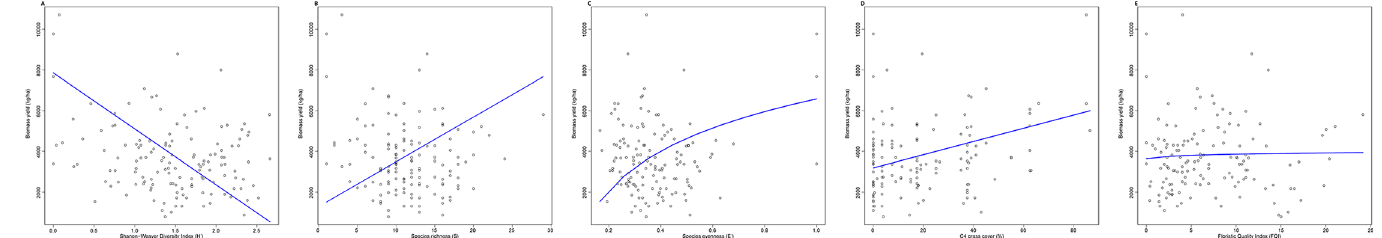
Fig 4. Variable plots for the model average for 2009 data. The regression line for multiple regression is displayed as the intercept and slope for the indicated predictor variable with the mean of all other variables held constant. Coefficients for each model are listed in Table 4. Log-transformed variables have been back-transformed. (A) The relationship between the Shannon-Weaver diversity index (H 0 ) for the plant community within 1 m2 plot and biomass yield (kg/ha). (B) The relationship between plant species richness (S) within 1 m 2 plots and biomass yield (kg/ha). (C) The relationship between plant species evenness (E 0 ) within 1 m 2 plots to biomass yield (kg/ha). (D) The relationship between the percent of C4 grass cover within 1 m 2 plots to biomass yield (kg/ ha). (E) The relationship between the Floristic Quality Index (FQI) within 1 m 2 plots to biomass yield (kg/ha).